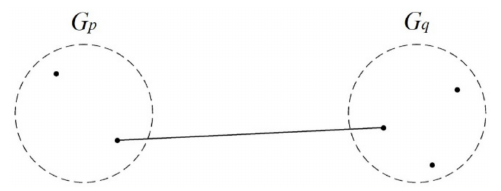
Figure 1. Conceptual diagram of the single linkage.